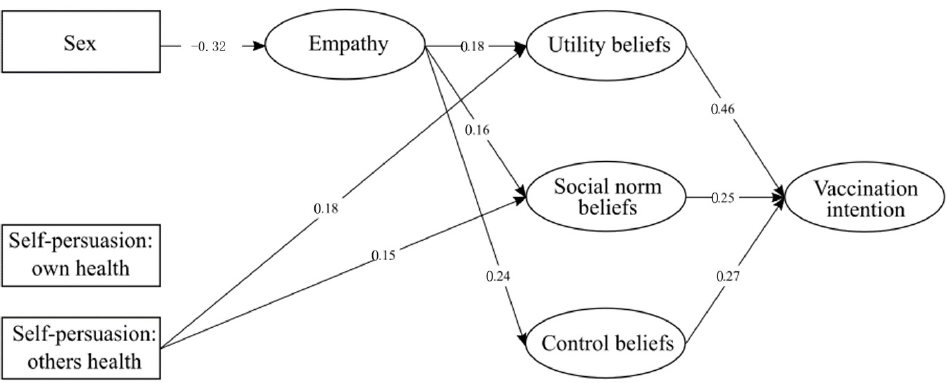
Figure 1. Simplified SEM model for Study 1 with only significant